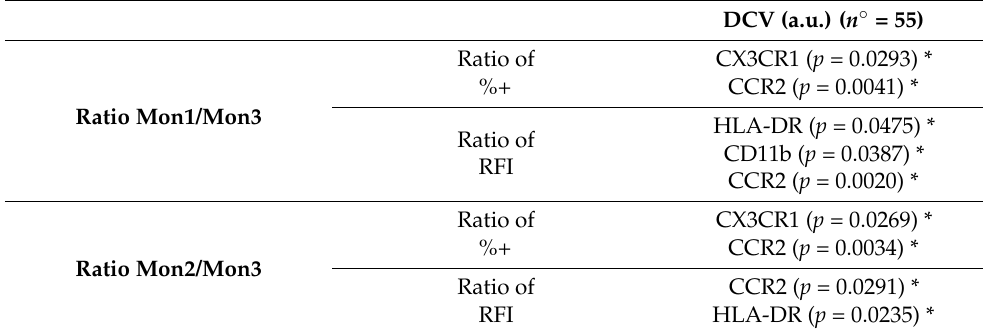
Table 4. Multiple regression of the ratio of monocyte subsets’ markers expression and